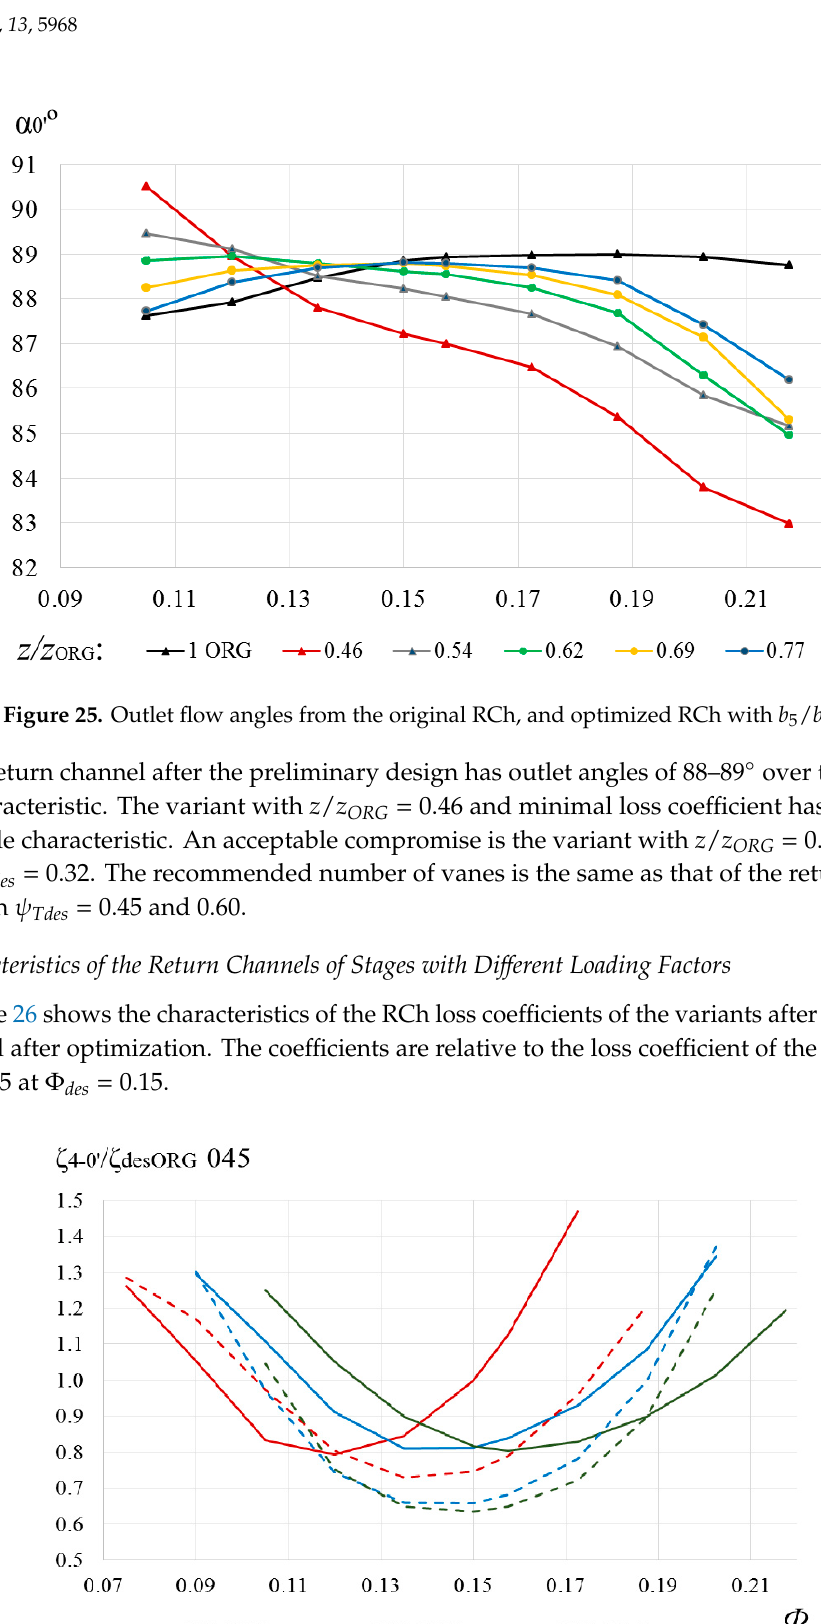
Figure 26. Characteristics of the loss coefficients of the RCh of the stages with Φ des = 0.15 and di ff erent loading factors ψ Tdes = 0.45, 0.60,